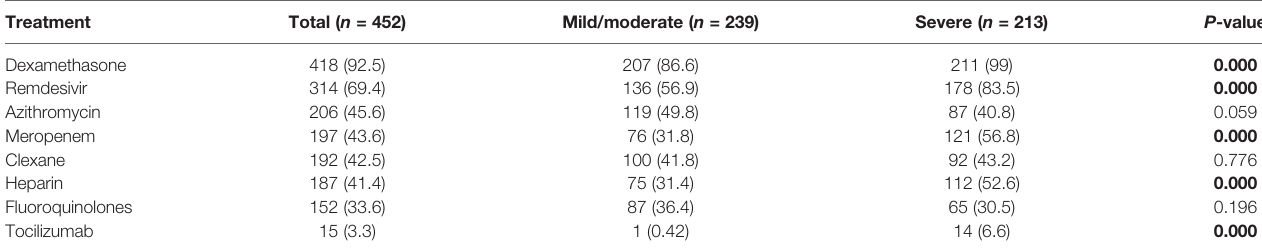
TABLE 5 | Treatment of 452 symptomatic COVID-19